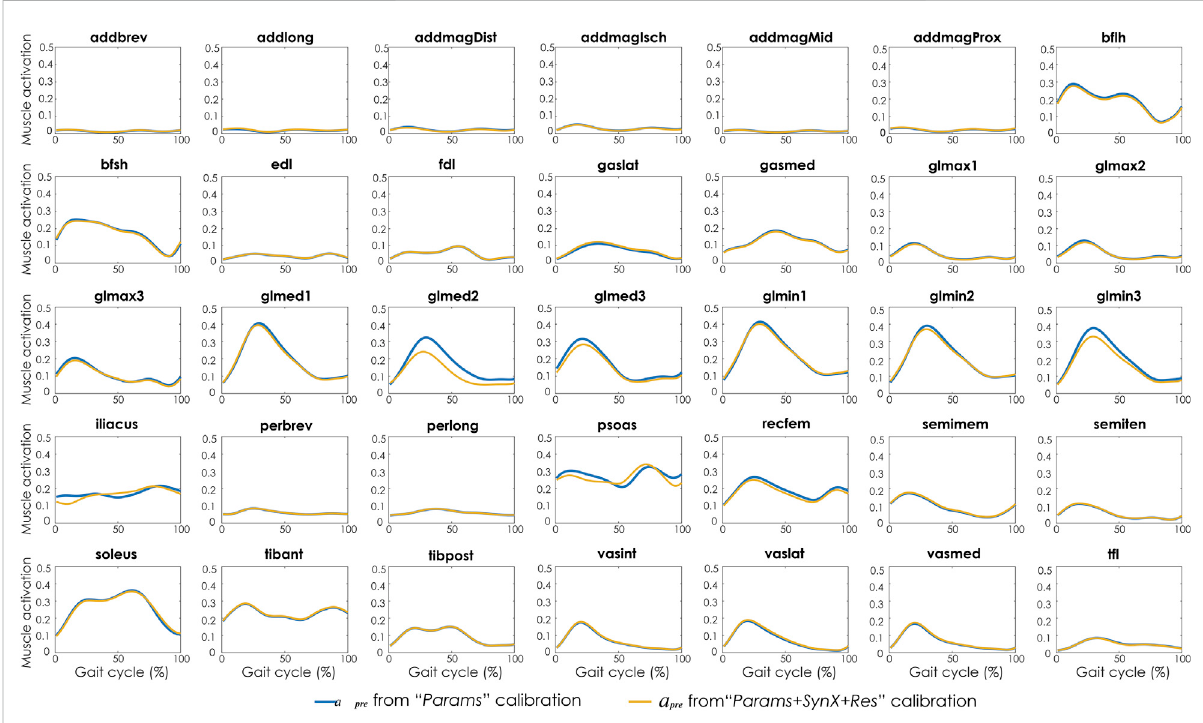
FIGURE 5 Average muscle activations across calibration trials and subjects from “ Params ” calibration (in blue), and “ Params + SynX + Res ” calibration (in yellow). Results for “ Params + SynX + Res ” calibration were generated using the best methodological combinations for analyzing experimentally measured walking motions (trial-speci fi c unmeasured and speed-speci fi c residual synergy vector weights with six synergies). Here, residual excitations were calibrated but not used to calculate muscle activations for “ Params + SynX + Res. ” Data are reported for the complete gait cycle, where 0% indicates initial heel-strike and 100% indicates subsequent